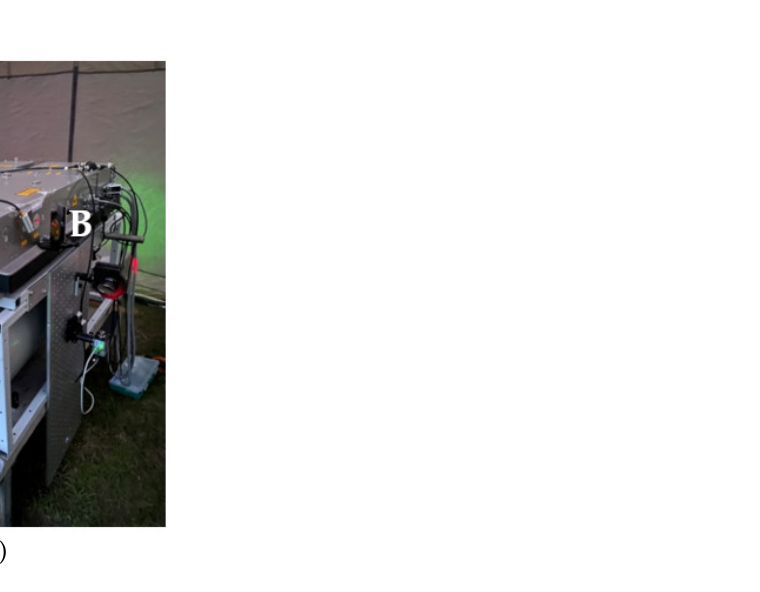
Figure 3. ( а ) Scheme of in situ measurements of horizontally configured lidar with an output mir- ror: transmitter (1), receiver (2), and control and data acquisition and processing system (3), sta- tionary post for measuring various meteorological parameters of the atmosphere, including the Picarro gas analyzer Picarro (4), and quad bike or all-terrain vehicle (AVT) with mirror reflector (5)); ( b ) mobile IR lidar: laser with optical parametric oscillators (OPO) (A), output mirror (B), and receiving aperture of the telescope (C).